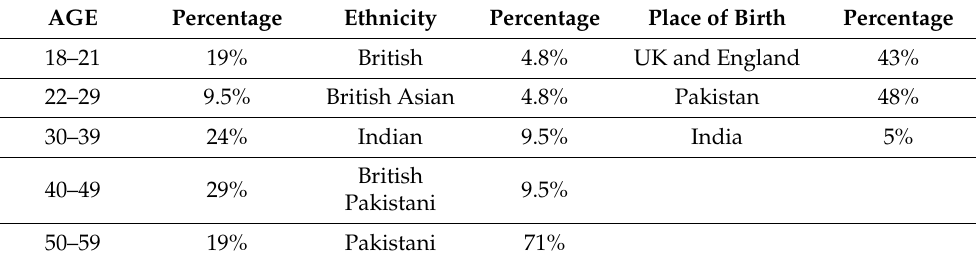
Table 1. Age, ethnicity and place of birth of respondents.